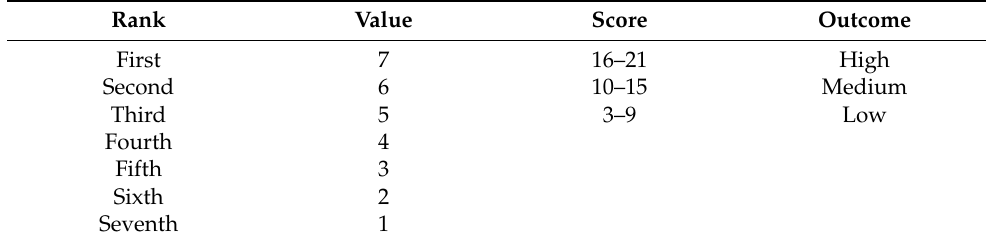
Table 4. Values for each rank and the range of score determining the